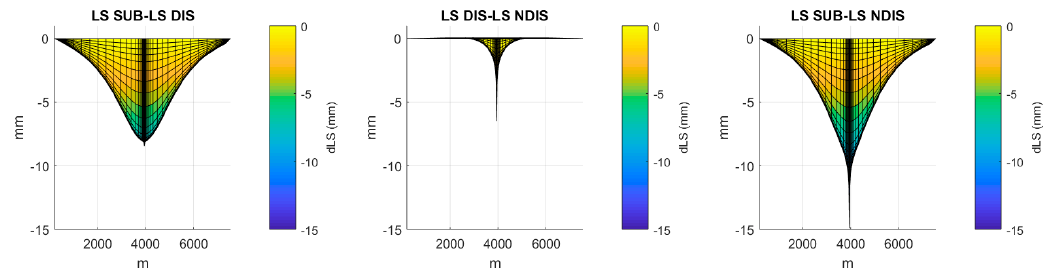
Figure 10. Differences between subsidence calculated by the three models. LS SUB-LS DIS: difference between subsidence calculated by SUB model and DIS model. LS DIS-LS NDIS: Difference between subsidence calculated by DIS model and NDIS model. LS SUB-LS NDIS: Difference between subsidence calculated by SUB model and NDIS model.